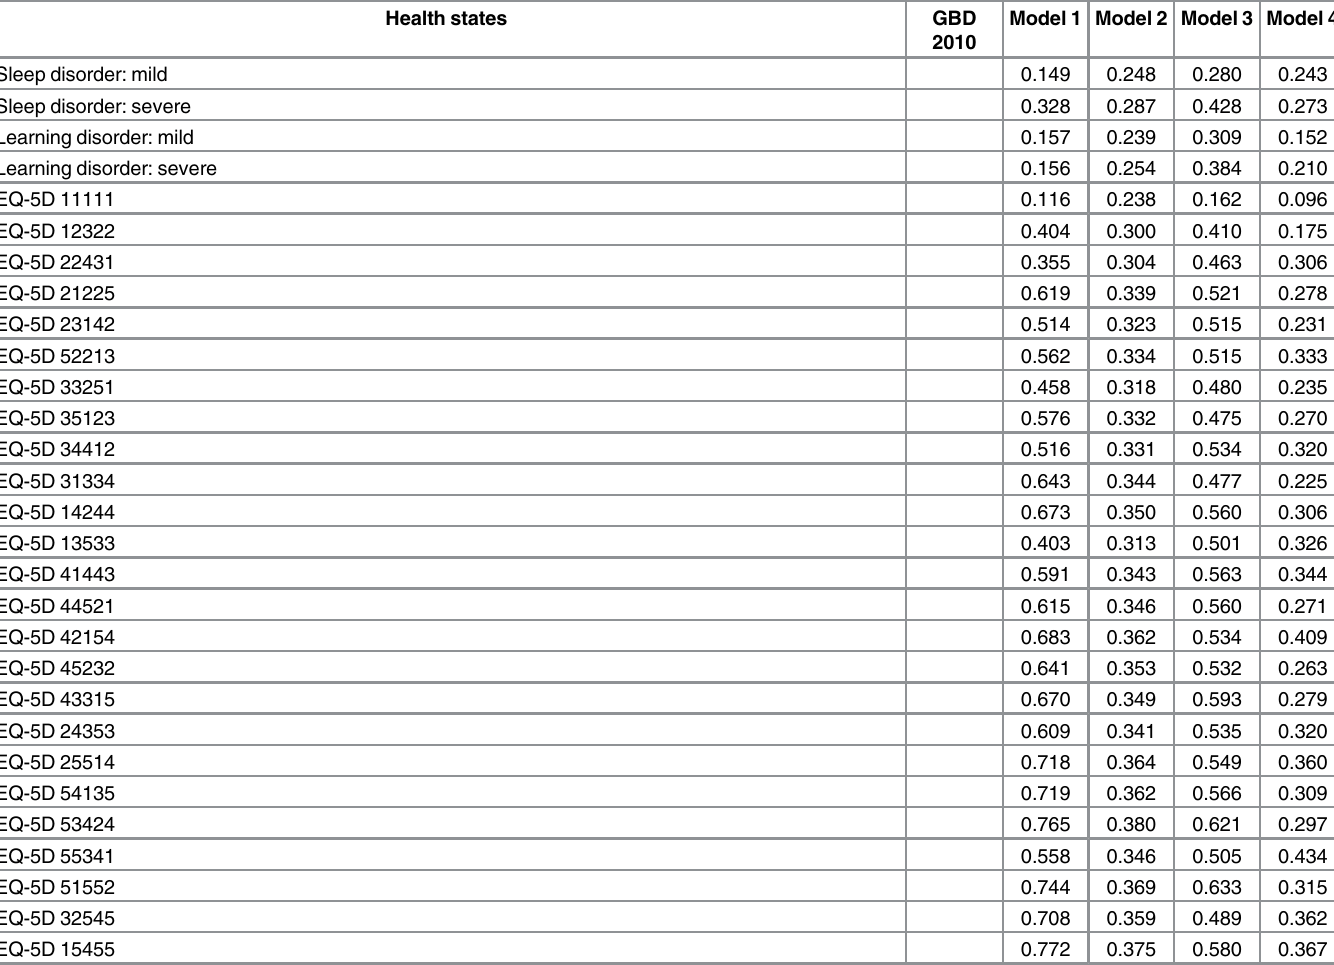
22.3% in Model 3, and 85.0% in Model 4. In particular, all health states had a value between 0.2 and 0.5 in Model 2. The disability weights were distributed most evenly in Model 1. The Pearson correlation coefficients between the disability weights of health states for the GBD 2010 disability weight study and those of the health states for the current models are shown in Fig 1. The highest Pearson correlation coefficient was 0.802 in Model 2, followed by 0.796 in Model 1, 0.681 in Model 3, and 0.574 in Model 4. All Pearson correlation coefficients were statistically significant. Based on the distribution of disability weights of the health states for each model and the Pearson correlation coefficients, the paired comparison-only model based on probit regression was selected as the best model for estimating the disability weight in South Korea and for main- taining the simplicity of the analysis. The estimated disability weights and 95% confidence intervals for the 256 health states (excluding ‘ full health ’ and ‘ being dead ’ ) from Model 1 are shown in Table 4. The health state with the highest disability weight (0.912) was ‘ Spinal cord lesion at neck level: untreated ’ (N191 in Table 4), followed by ‘ Spinal cord lesion below